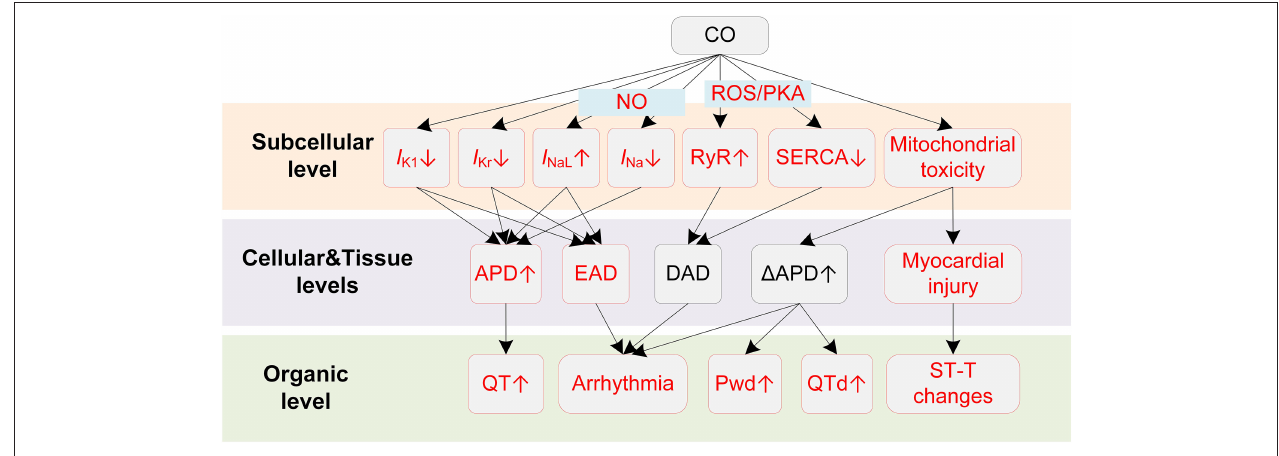
FIGURE 3 | Potential mechanisms underlying CO-induced arrhythmias. Red boxes indicate effects of CO that have been explicitly